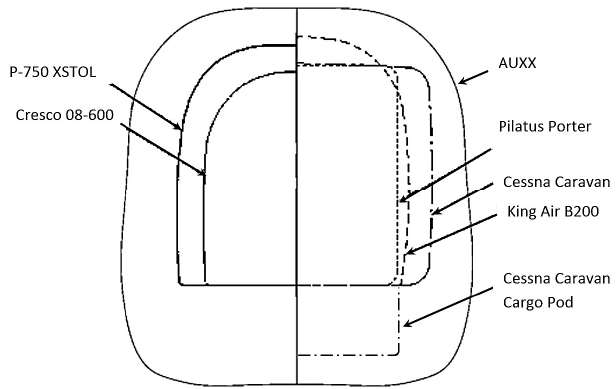
Figure 19. AUXX frontal area comparison.